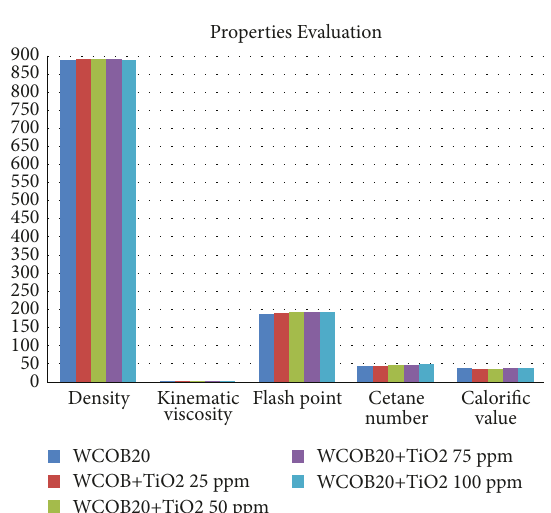
Figure 4: Graphical representation of the physical and chemical characteristics of mixed biodiesel fuels, both with and without